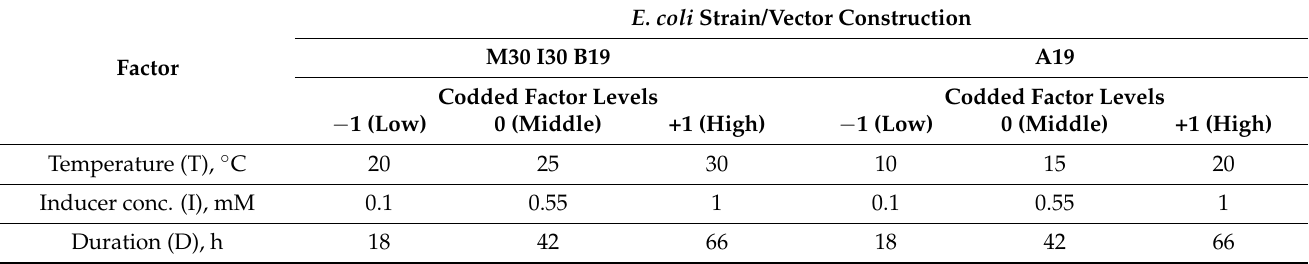
Table 4. Experimental level of factors affecting the olive recombinant HPL production for each host-vector combination. E. coli Strain/Vector Factor